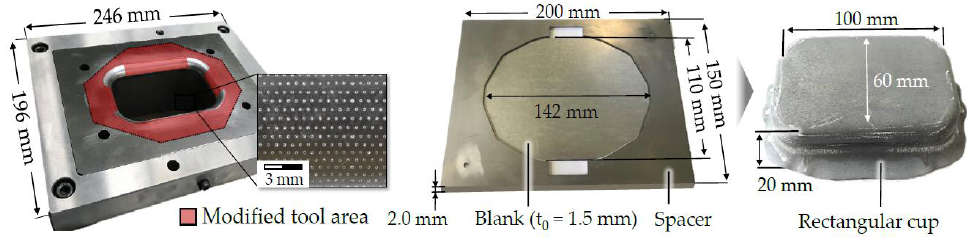
Figure 6. Laser-implanted tooling system for hot stamping rectangular cups.